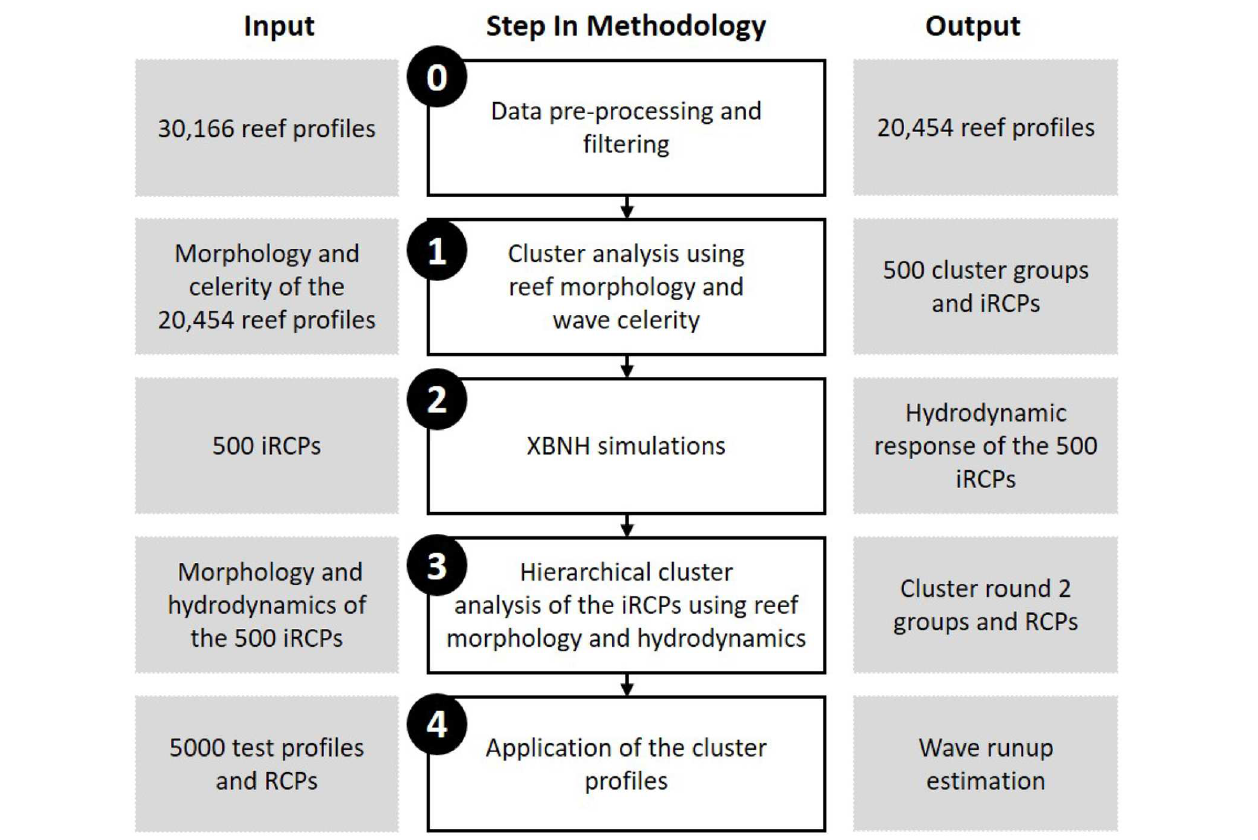
FIGURE 2 | The methodology used to reduce the initial dataset of coral reef topobathymetric cross-shore profiles to the representative cluster profiles (RCPs). Steps 0 and 1 highlight the first data reduction step to create the 500 initial representative cluster profiles (iRCPs), Steps 2 and 3 are used to further cluster the profiles and to form the final RCPs, and Step 4 includes using the RCPs for wave runup